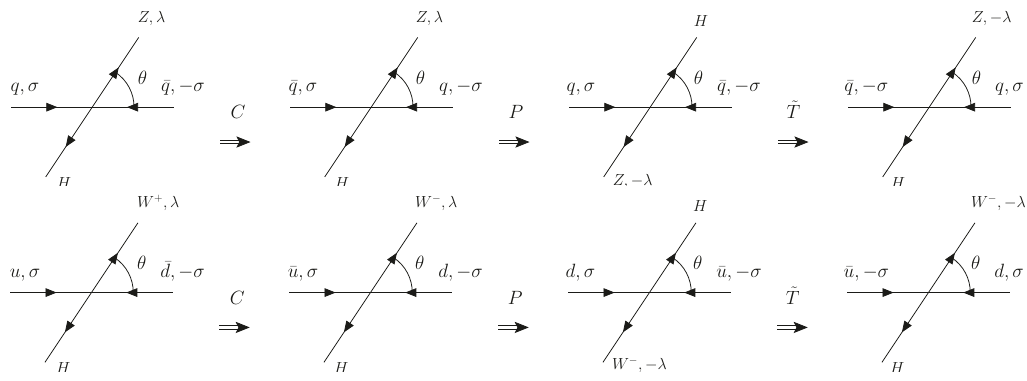
ZH (upper) and those in the process !